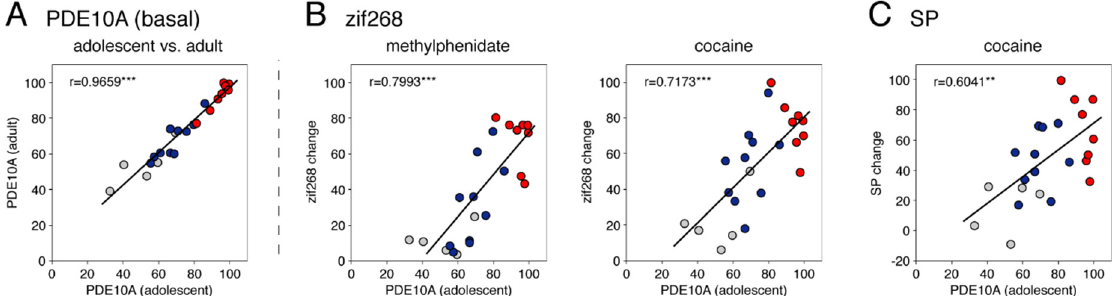
Figure 5. Comparison of basal PDE10A expression in adolescent and adult rats ( A ) and the relation- ship between basal PDE10A expression and changes in zif268 ( B ) and substance P expression ( C ) induced by acute treatment with methylphenidate or cocaine in adolescents. Scatter plots depict cor- relations between basal PDE10A expression in adolescents (vehicle control, in % of max.; Experiment 2) and that in adults (S/V, intact side, in % of max.; Experiment 1) ( A ), and increases in expression of zif268 and substance P (SP) after acute injection of methylphenidate (5 mg/kg; in % of max. cocaine) or cocaine (25 mg/kg; in % of max.) in adolescents ( B , C ), for the eight sensorimotor sectors (red dots), the ten associative sectors (blue dots) and the five limbic sectors (gray dots). ** p < 0.01, *** p <